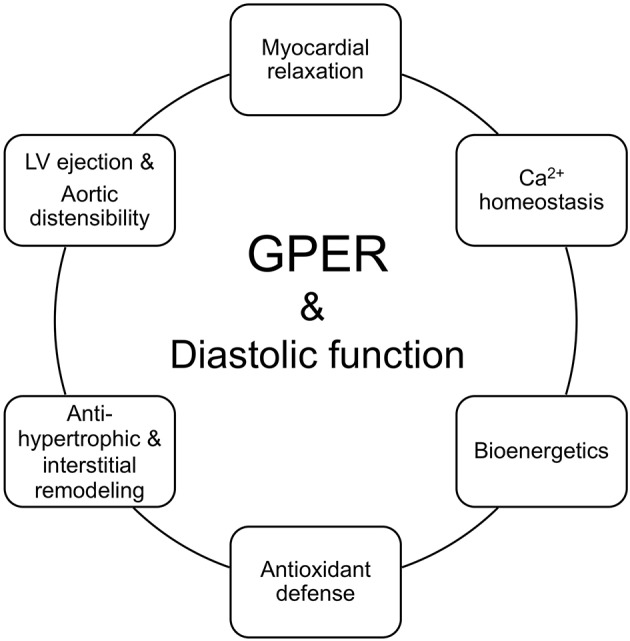
GPER in the functional circle of diastology of the female heart. Diastolic function is an appropriate barometer of overall heart health as it reflects cellular and subcellular events responsible for maintaining myocardial relaxation, cardiomyocyte calcium homeostasis, mitochondrial bioenergetics, antioxidant defense, left ventricular (LV) and myocyte structure, and proximal aortic distensibility. Loss of ovarian estrogens due to aging/menopause or surgery lead to impairments in myocardial/cardiomyocyte relaxation, increased mitochondrial reactive oxygen species and impaired oxidant defenses and bioenergetics, hypertrophic and/or interstitial remodeling, and aortic stiffening. Preclinical studies show that activation of the non-canonical estrogen receptor, GPER, by its agonist G1 or estradiol (E2) favorably regulates and likely integrates components of relaxation, mitochondrial function, LV structure, LV ejection, and aortic compliance, to preserve diastolic function in the female heart.